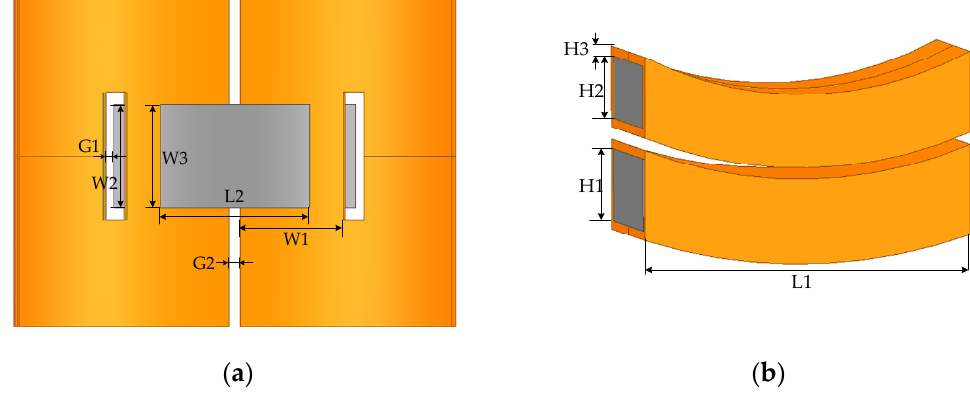
Figure 3. Schematic diagram of two structure sizes. ( a ) Arc-shaped core (Top view); ( b ) Double dipole core (Front view).